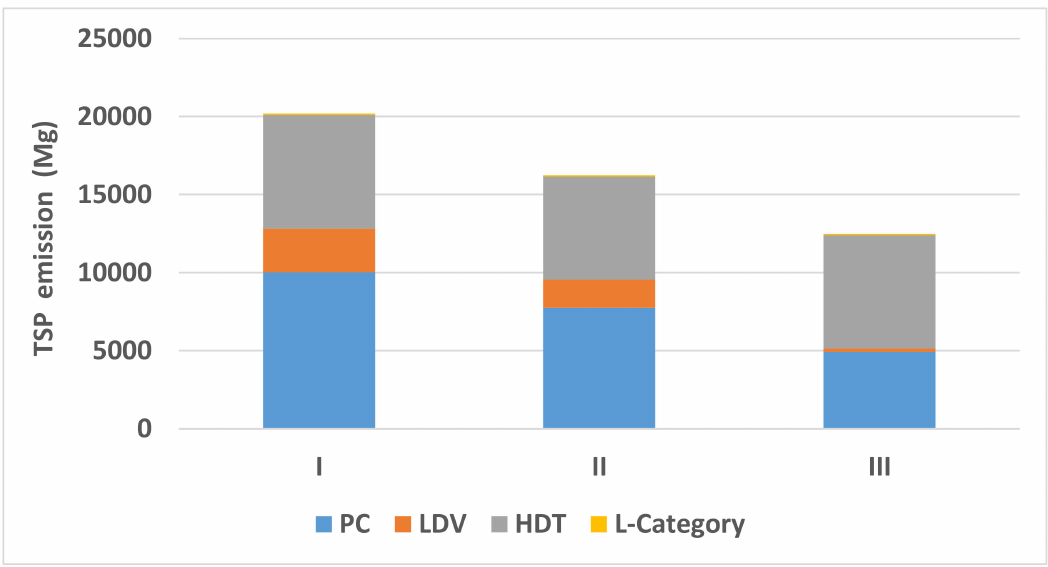
Figure 3. Comparison of Total Suspended Particles (TSP) emissions for three scenarios.